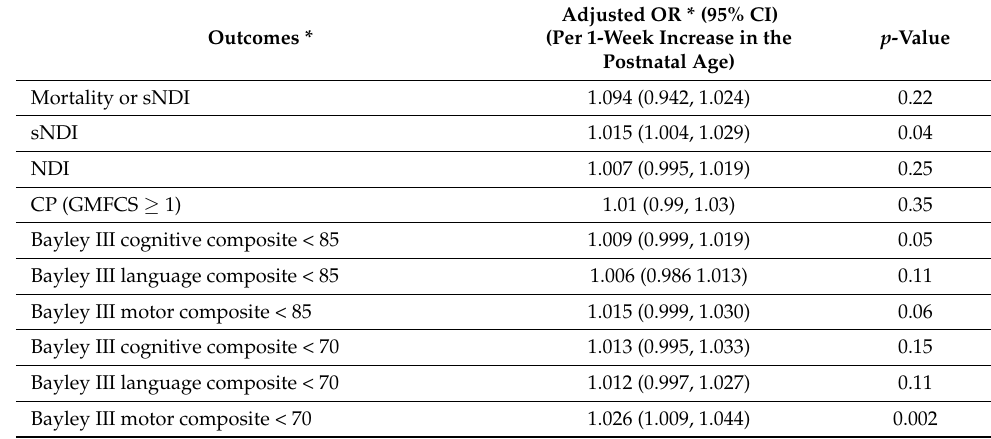
Table 5. Adjusted odds of neurodevelopmental outcomes for the age at first systemic postnatal steroid